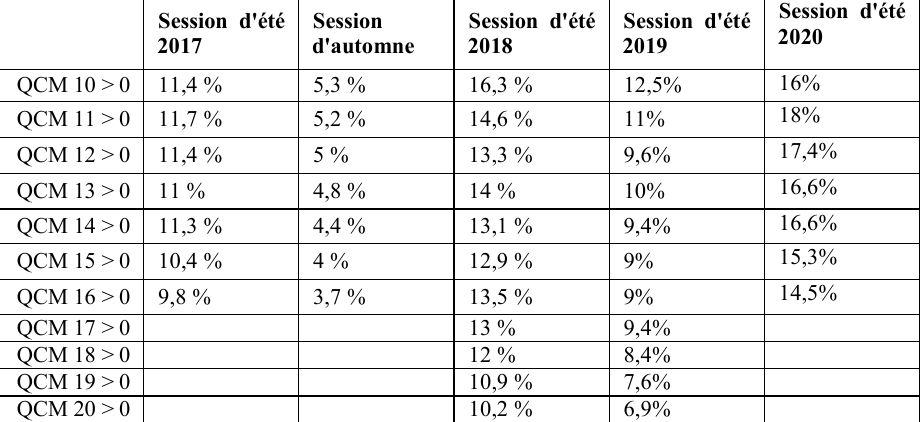
Tableau 7. Pourcentages de validation des QCM selon les